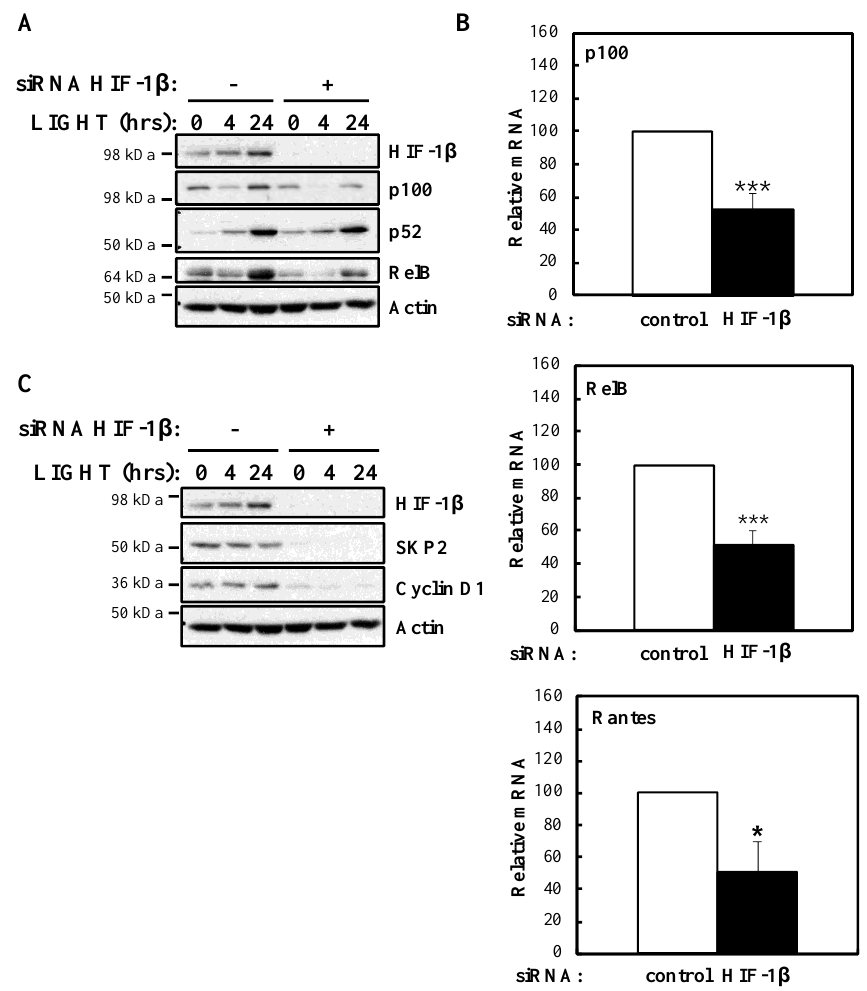
Figure 2. HIF-1 β is required for full NF- κ B activity in response to LIGHT. ( A ) HeLa cells were transfected with control or HIF-1 β siRNA oligonucleotides. Where indicated, cells were treated with 100 ng / mL LIGHT for 4 or 24 h prior to whole cell lysis and Western blot analysis. Actin was used as a loading control. ( B ) HeLa cells were transfected with control or HIF-1 β siRNA oligonucleotides for 24 h prior to treatment with 100 ng / mL LIGHT for other 24 h prior to lysis and RNA extraction. Following cDNA synthesis, qPCR was performed using primers for the indicated targets. Graphs depict mean and SEM from three independent biological experiments. Student t -test analysis was performed for each gene and levels of significance determined as: * p < 0.05, *** p < 0.001. ( C ) HeLa cells were treated and analysed as in 2A .